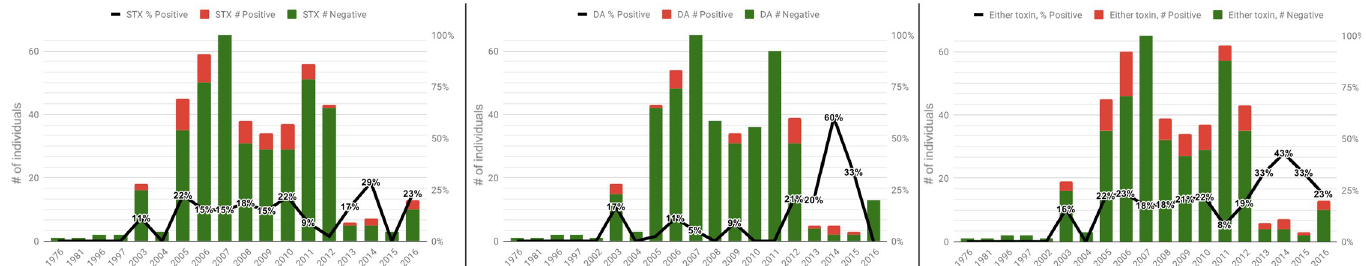
Fig 8. Animals testing positive for saxitoxin, domoic acid, or either toxin, by